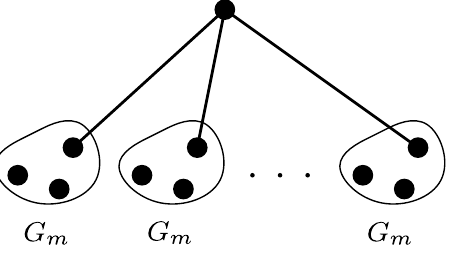
nG m  is identical to the Star graph, where every leaf is replaced by a small graph N ( )